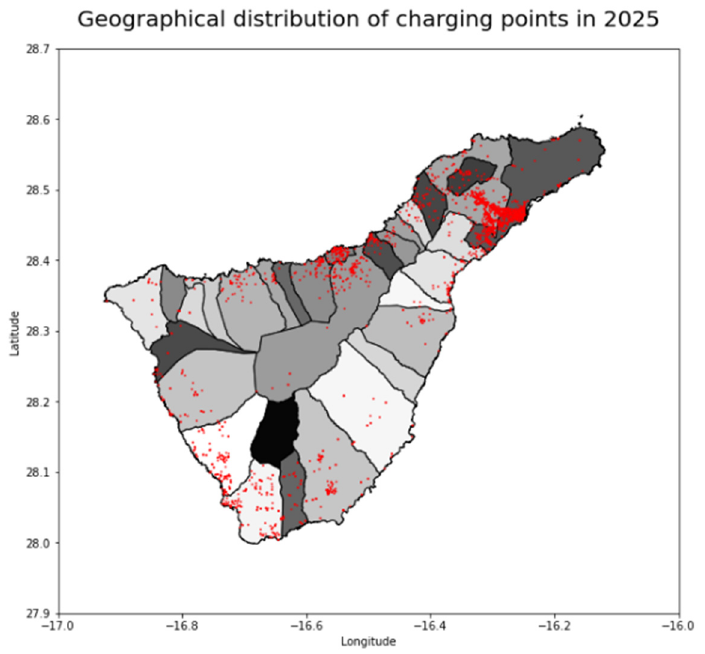
Figure 12. Map of the distribution of the charging points obtained in Tenerife for the year 2025.